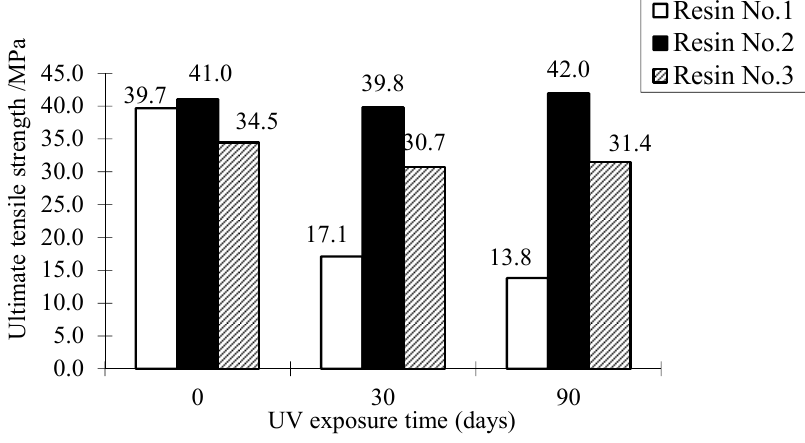
Figure 12. Effect of UV exposure on the ultimate tensile strength of resin.